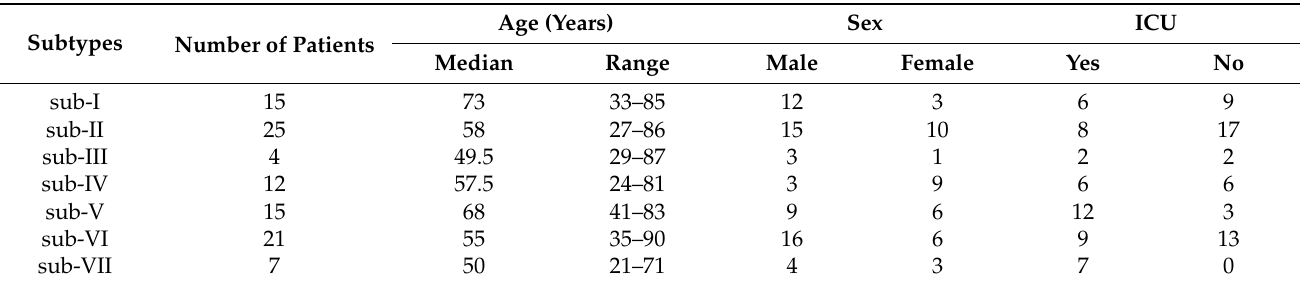
Table 5. Distributions of basic clinical and pathological characteristics.